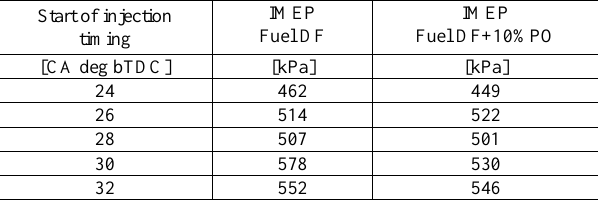
Table 3. Average IMEP for reference fuel and Diesel Fuel+10%PO